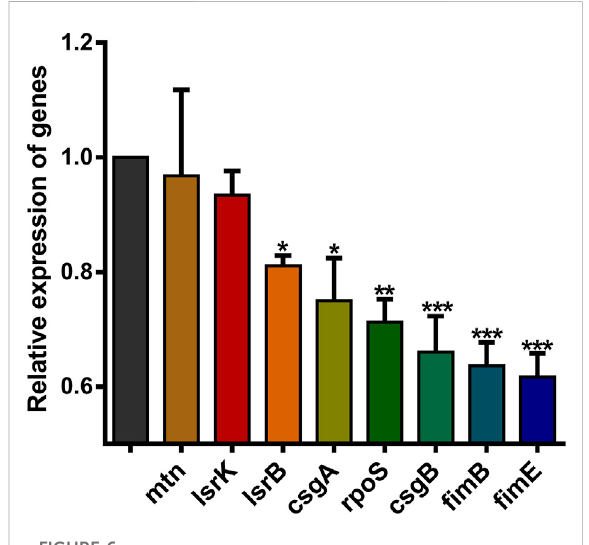
FIGURE 6 Effect of luxS gene deletion on E. coli O101 QS-related genes and virulence genes expression. The results represent means ± standard deviations for three independent experiments. * p < 0.05, ** p < 0.01 and *** p < 0.001 versus the control group.